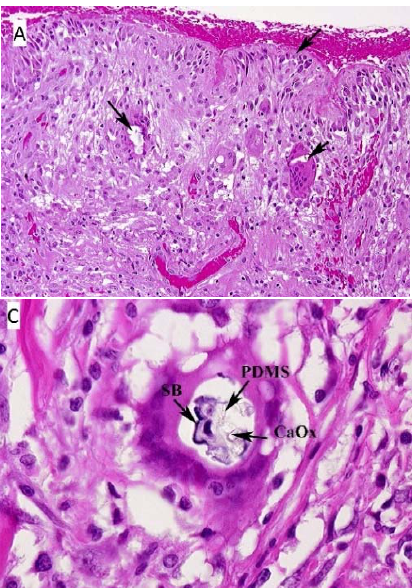
Figure 1. ( A ) Fibrous capsule surrounding the implant, right. The surface of the tissue lies adjacent to the silicone breast implant and forms the “pseudosynnovium.” This pseudosynnovium is composed of amorphous eosinophilic material and mononuclear cells. Of note are several foreign body giant cells containing clear silicone gel. There is a chronic inflammatory infiltrate scattered among the fibroblasts, fibrous tissue, and collagen. (HE, 10 × ). ( B ) Fibrous capsule surrounding implant, right. A high-power view of the above tissue shows silicone gel within the giant cell that is embedded in fibrous tissue. There are also scattered chronic inflammatory cells, congested blood vessels, and surgical related hemorrhage. (HE, 100 × ). ( C ) Fibrous capsule surrounding implant, left. High power view of previous section. In the center of the multinucleated giant cell are fragments of Schaumann body (annotated on the image as SB), and refractile clear crystalline material consistent with calcium oxalate (annotated on the image as CaOx). (HE, 100 × ). ( D ) Axillary lymph node, left. There is clear refractile globular material in the center of the giant cell of the epithelioid granuloma consistent with silicone gel. In addition, fragments of a Schaumann body can be seen around the outer edge of the silicone gel. (HE, 100 × ). Arrows on the HE images, unless designated point towards areas of interest such as migrated